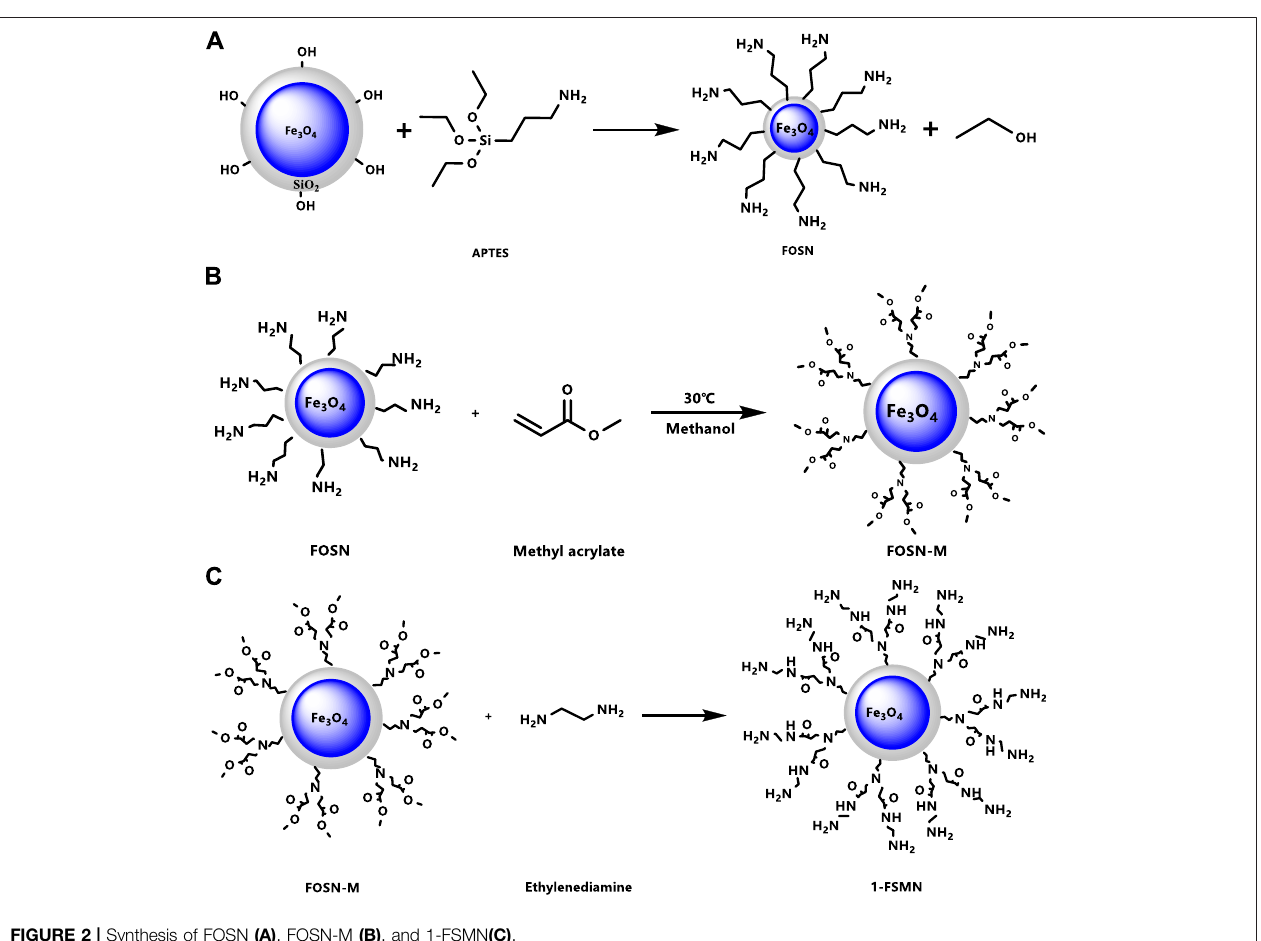
FIGURE 2 | Synthesis of FOSN (A) , FOSN-M (B) , and 1-FSMN (C) .